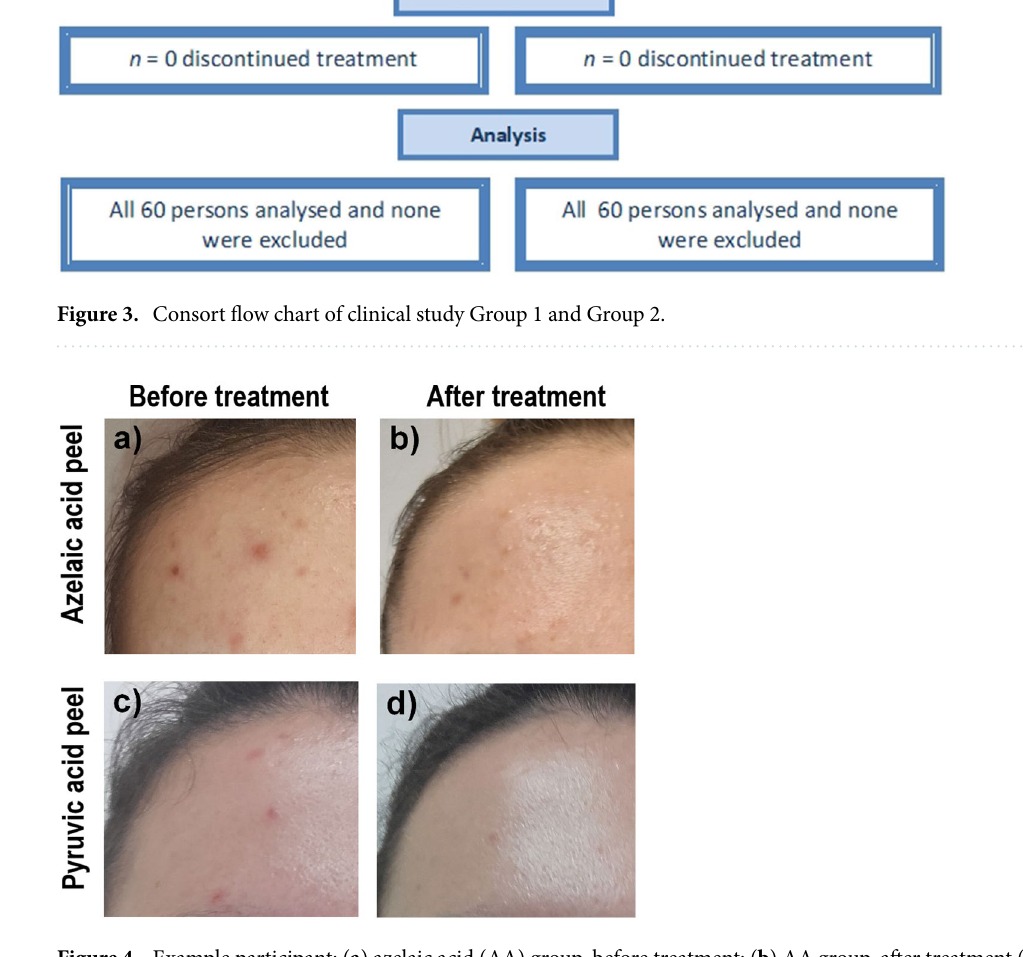
Figure 4. Example participant: ( a ) azelaic acid (AA) group, before treatment; ( b ) AA group, after treatment ( c ) pyruvic acid (PA) group, before treatment; ( d ) PA group, after